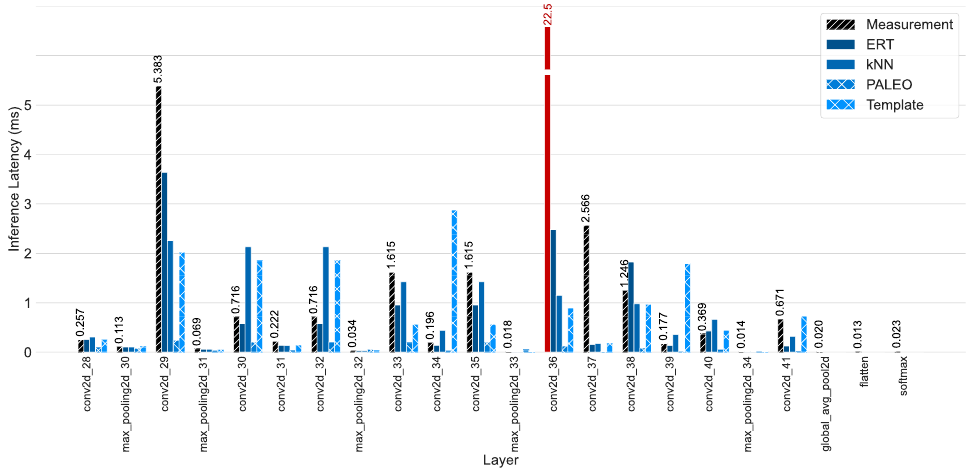
Figure 7. The measured and estimated layerwise inference latency of the test network. The mea- surement outlier has been marked with red and is represented by an interrupted bar to fit into the